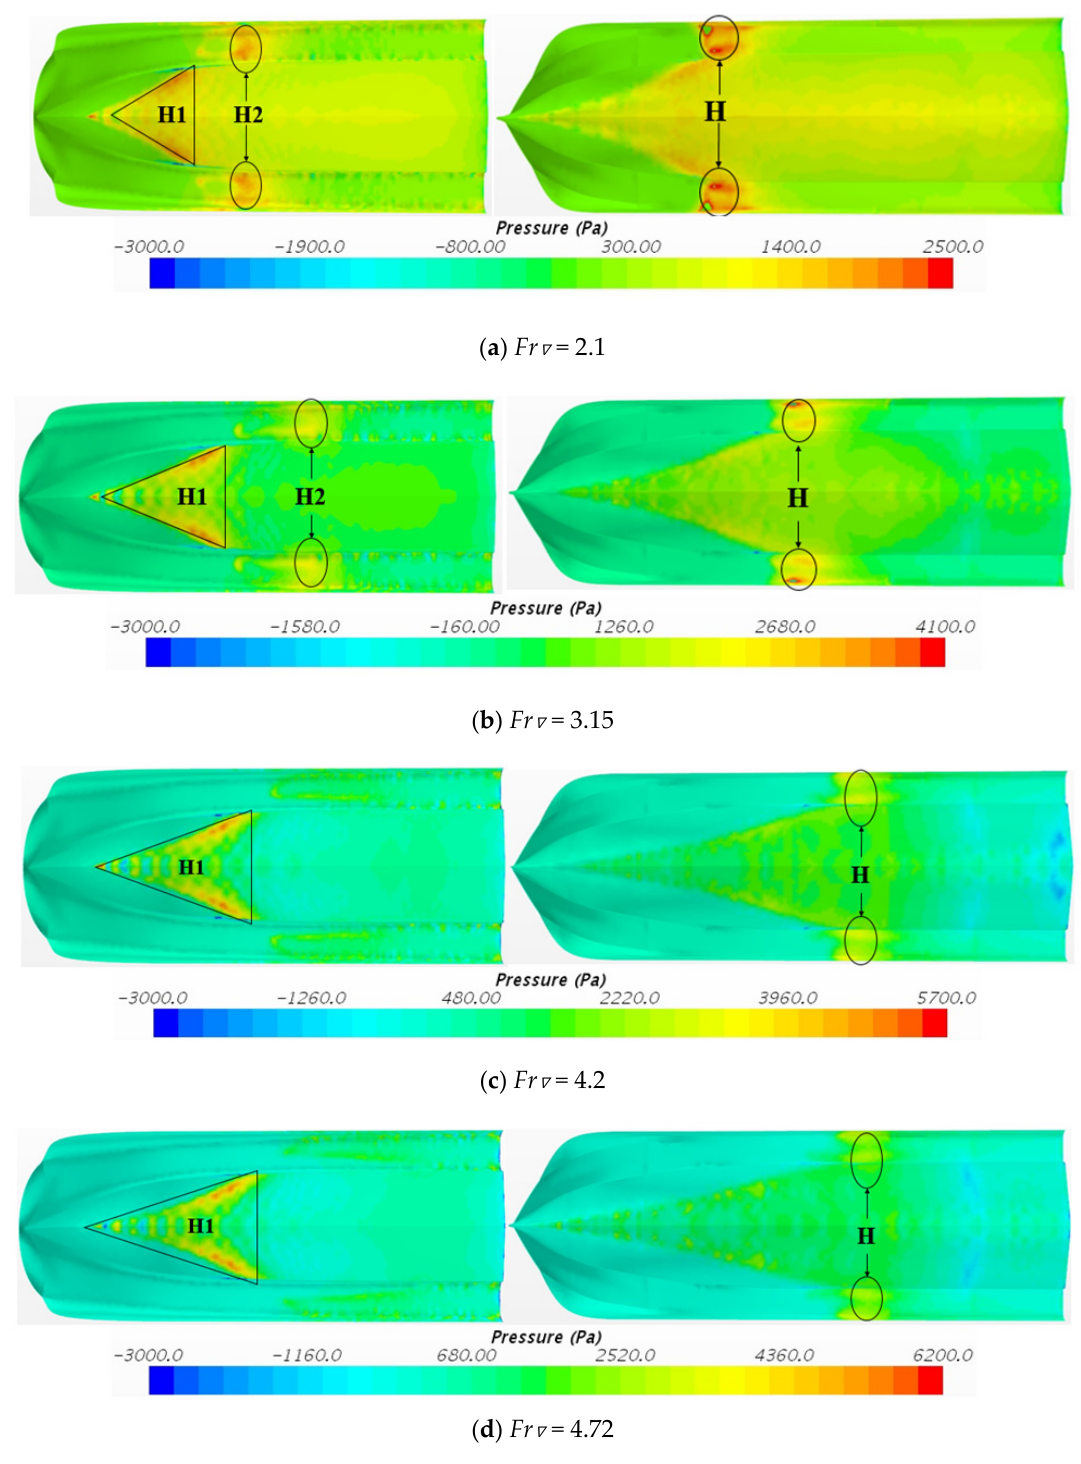
Figure 15. Pressure distribution analysis of Model a (left) and Model b (right).